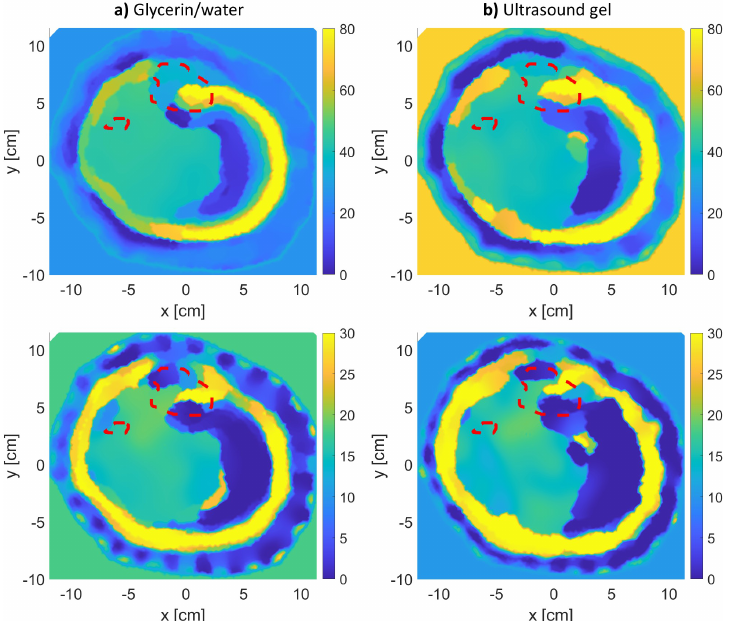
Figure 6. The real ( top row ) and imaginary ( bottom row ) relative complex permittivity results for leg model 3: ( a ) using glycerin/water matching medium, and ( b ) using the ultrasound gel matching medium. The red-dotted lines indicate the bones’ actual